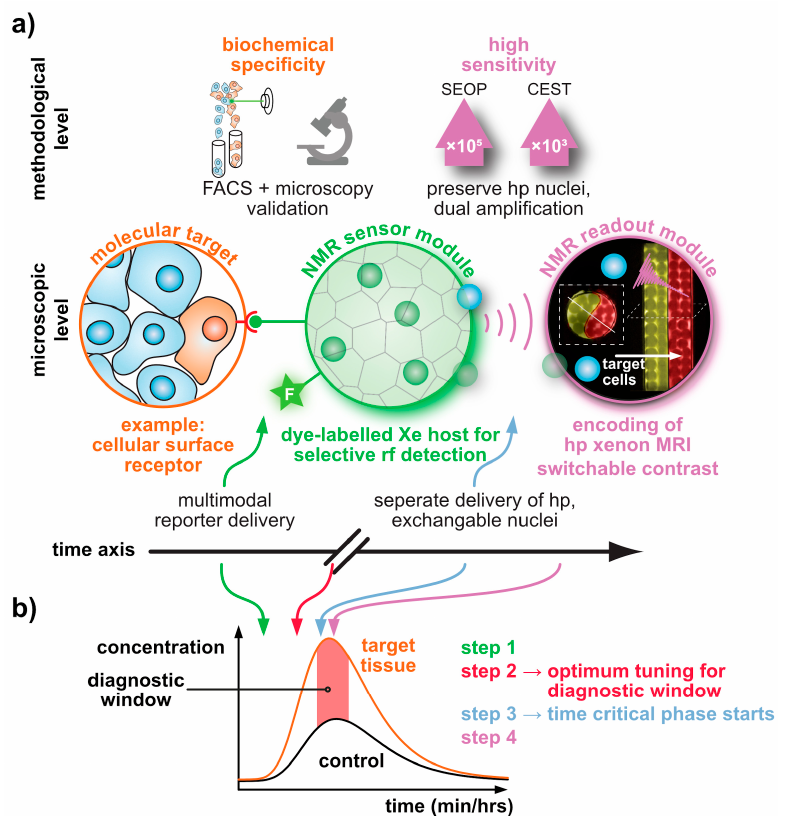
Figure 2. Separating the sensing and the detection module for functionalized Xe. ( a ) The sensor unit is pre-delivered and can carry fluorescence markers for cross-validation with cell sorting (FACS) and microscopy. Spontaneous, reversible binding of the subsequently delivered hp 129 Xe combines high sensitivity from SEOP and chemical exchange saturation transfer (CEST) with high specificity. The lifetime of the hp nuclei is somewhat decoupled from the overall time it needs for sensor accumulation in the target tissue. ( b ) This decoupling allows to achieve an optimized diagnostic time window where the sensor concentration in target and control tissue di ff er